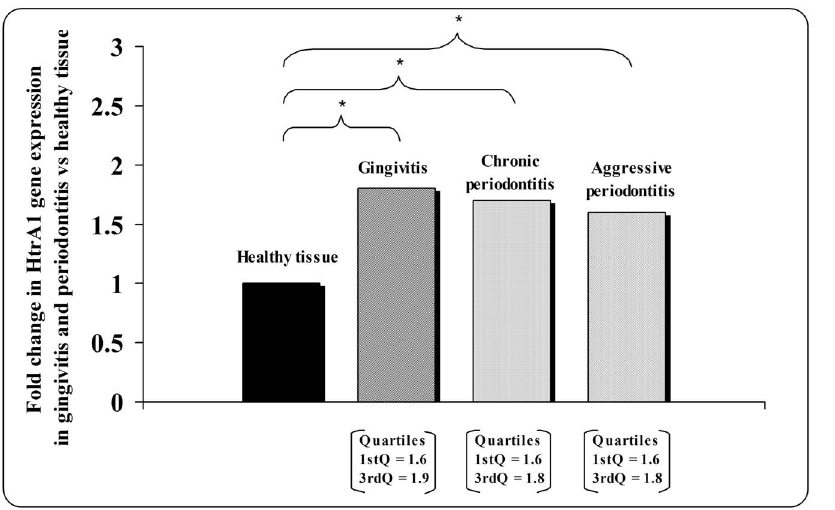
Figure 4. Quantitative real-time PCR of HtrA1 in periodontal tissues. Data are expressed as ‘‘fold changes’’ in relative gene expression of HtrA1 in periodontal diseases respect to the normal tissue. HtrA1 mRNA expression profile shows a statistically significant upregulation of its transcript in the analyzed periodontal diseases respect to healthy tissue. p , 0.05 (*); p , 0.01 (**).